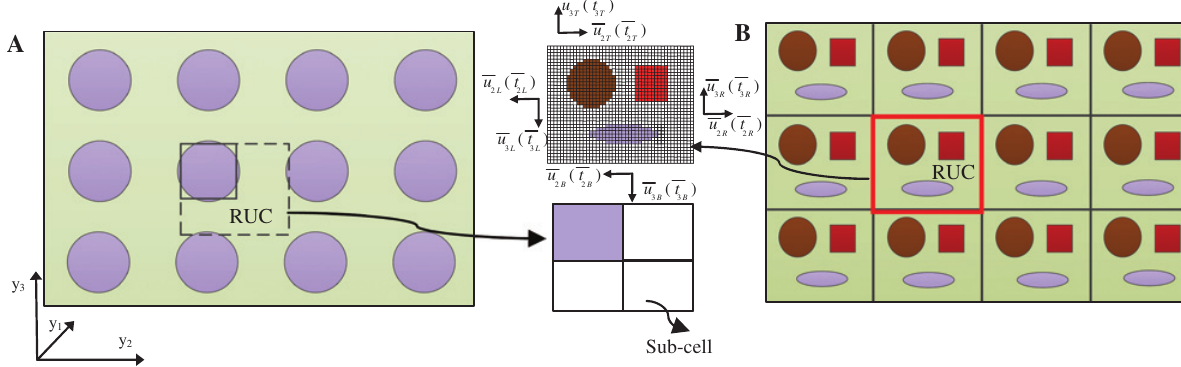
Figure 1 A micromechanical model of fiber-reinforced composites: (A) MOC and (B)